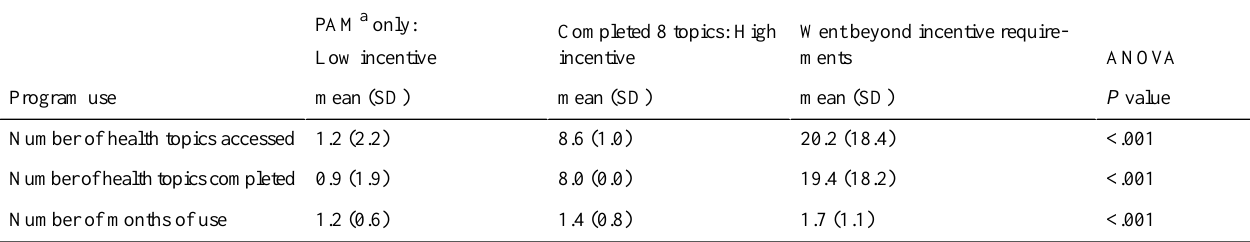
Table 2. Incentive response and use of online wellness/ self-management program.